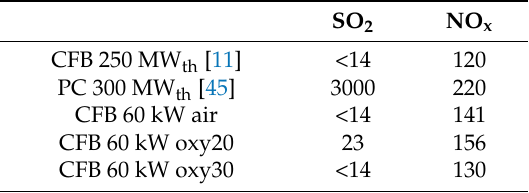
Table 6. Pollutant emissions from oils shale combustion, mg/Nm 3 at 6% O 2